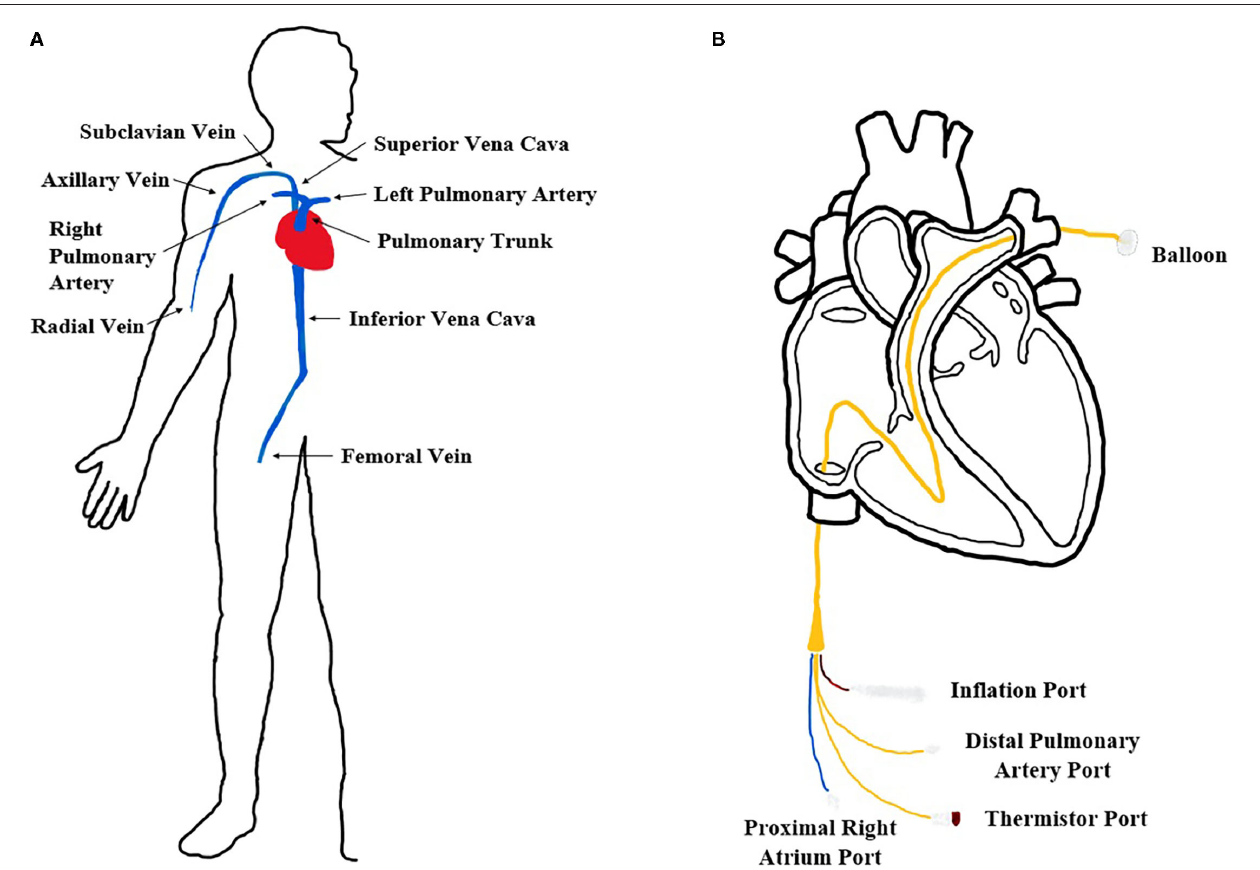
FIGURE 1 | Cardiovascular system and catheterization procedure. (A) Diagram of the human in vivo cardiovascular system in our body. (B) Expanded femoral insertion pulmonary artery catheterization procedure diagram.